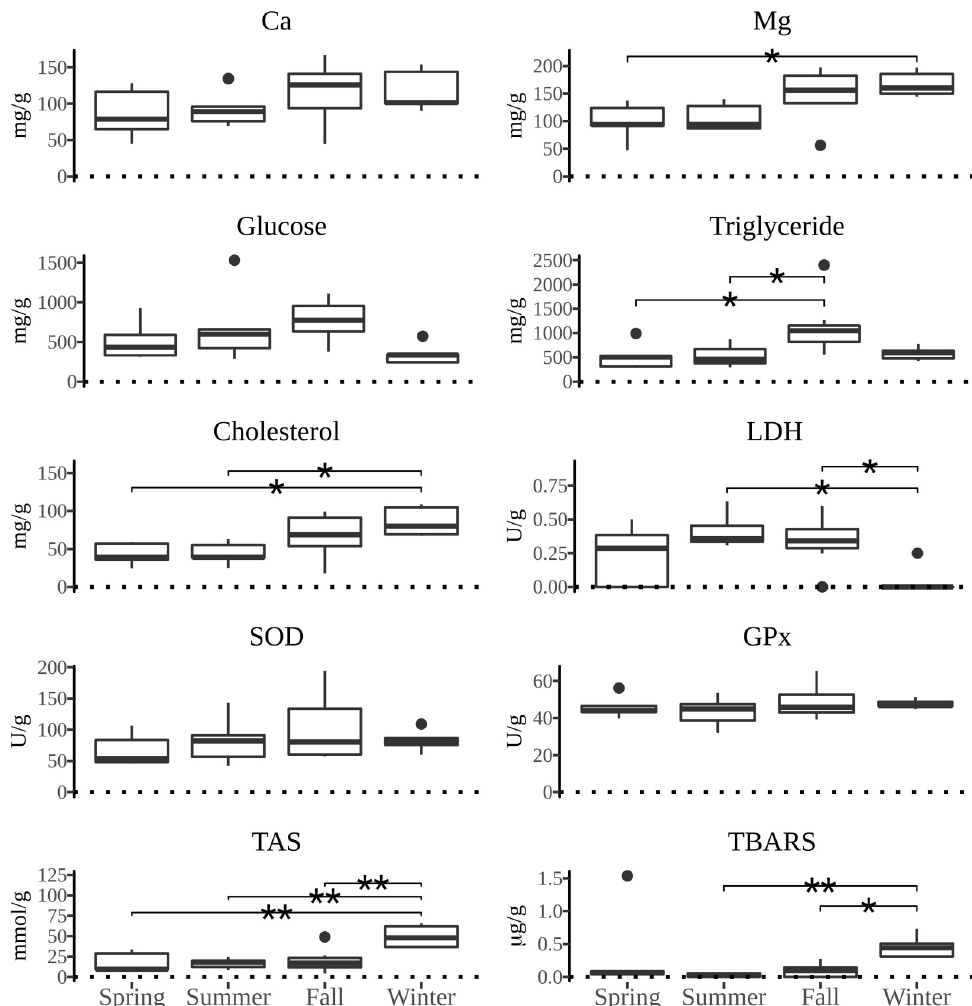
Fig 5. The boxplot distribution of biochemical parameters in digestive gland of Pecten jacobeus between seasons of the year. The lines above boxplots show the significance level ( � p < 0.05, �� p < 0.01, ��� p < 0.001) of differences between seasons in the pairwise comparison. The endpoints of the lines mark two seasons with significant